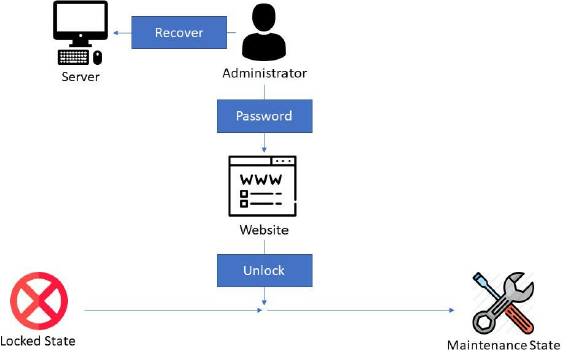
Figure 11. Unlock function: In the locked state, the monitor keeps protecting the server. All the sensitive data or programs are removed. The administrator should check the server status and fix the problem, and then input the password on the website to unlock the system.